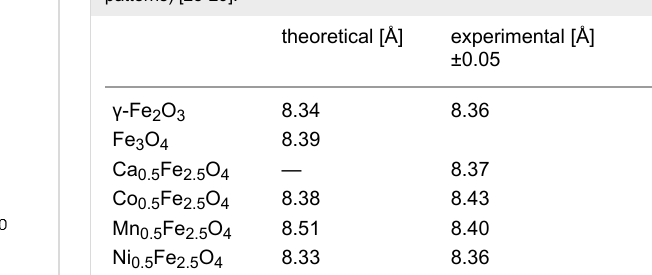
Table 2: Lattice constants (theoretical and calculated from diffraction patterns) [25-29].